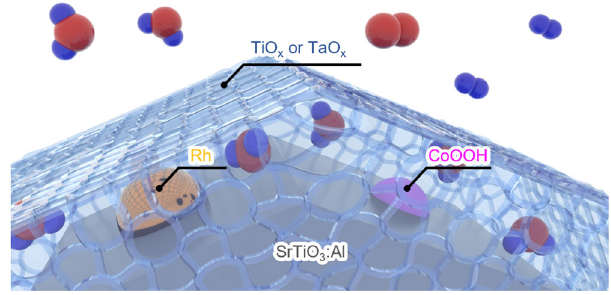
Fig. 1 | Schematic illustration of amorphous metal oxide coated, CoOOH/Rh loaded SrTiO 3 :Al. Red: O atom, blue: H